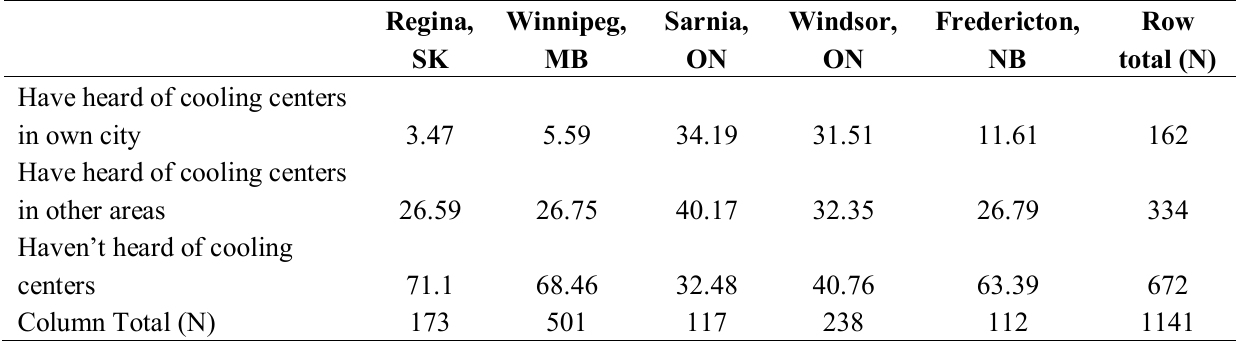
Table 17. Familiarity with cooling centers by area of residence. Percentage of